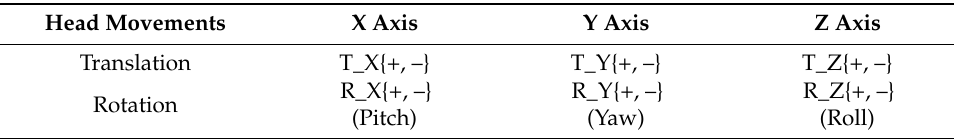
Figure 4. Definition of head rotation and translation. Table 1. Definition of the symbol representing the head movements.